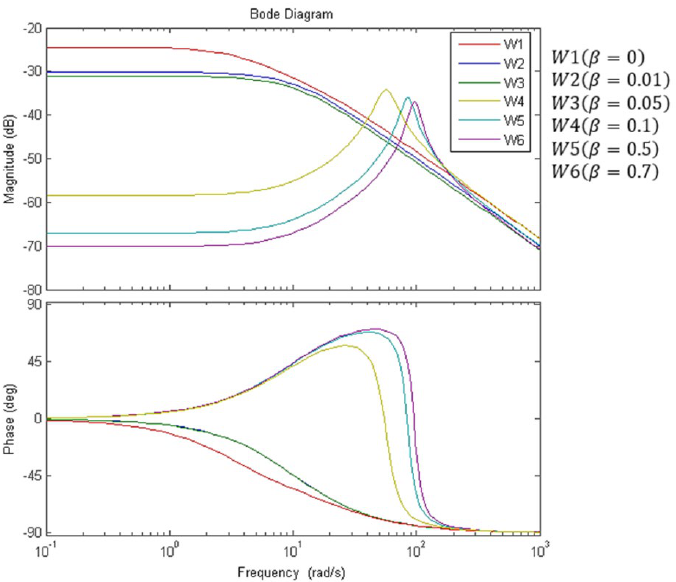
Figure 9. Frequency characteristics of the torque formation link for traditional motor.